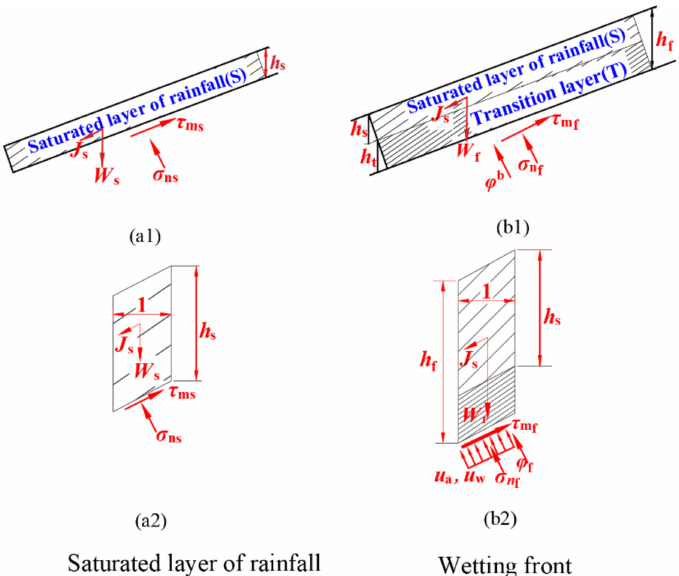
Figure 4. Mechanical model of the sliding surface for rainfall infiltration. ( a ) Mechanical model of saturated layer during rainfall ( b ) Mechanical model of wetting front during